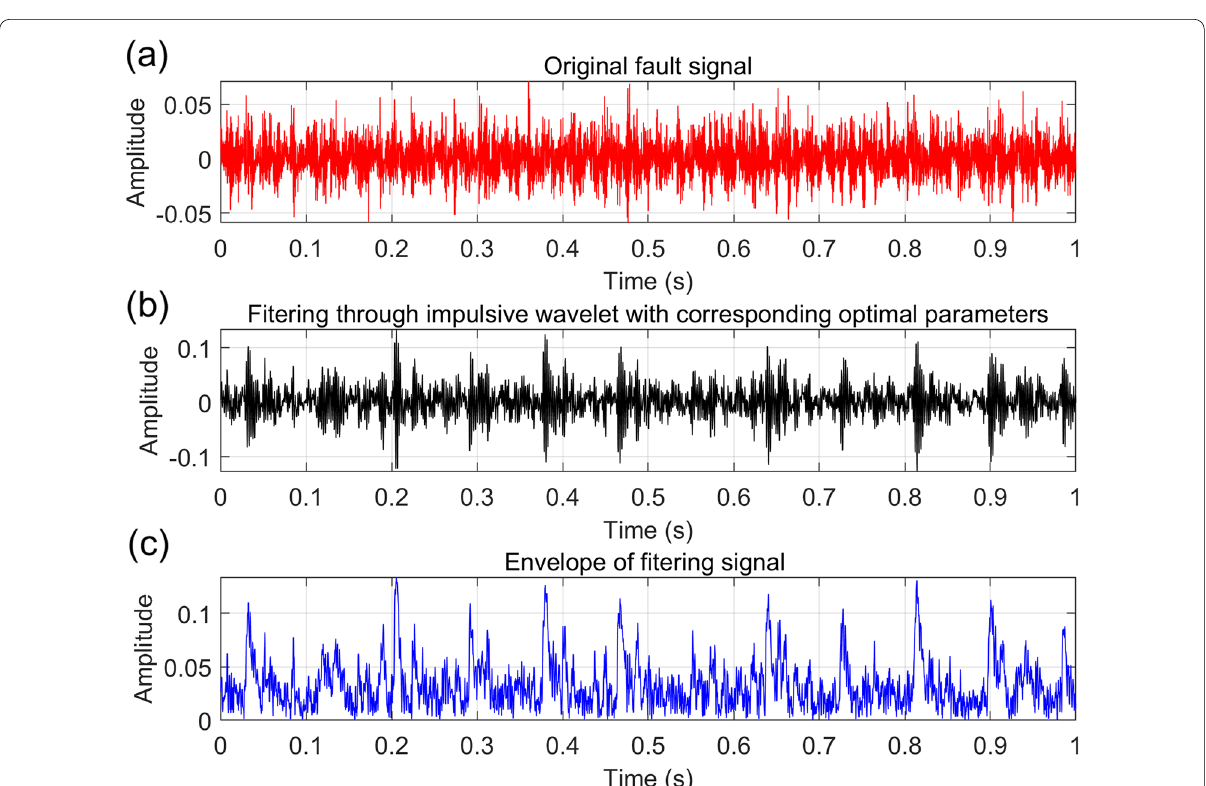
Figure 31 Gear fault signal processed by KM: ( a ) original signal, ( b ) signal after filtering by impulsive wavelet, and ( c ) envelope of the processed signal